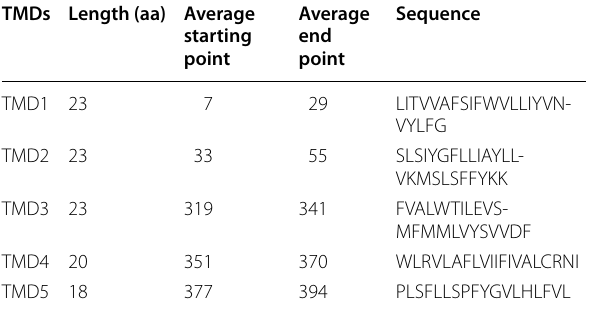
Table 2 Topology prediction of Predicted transmembrane helices of